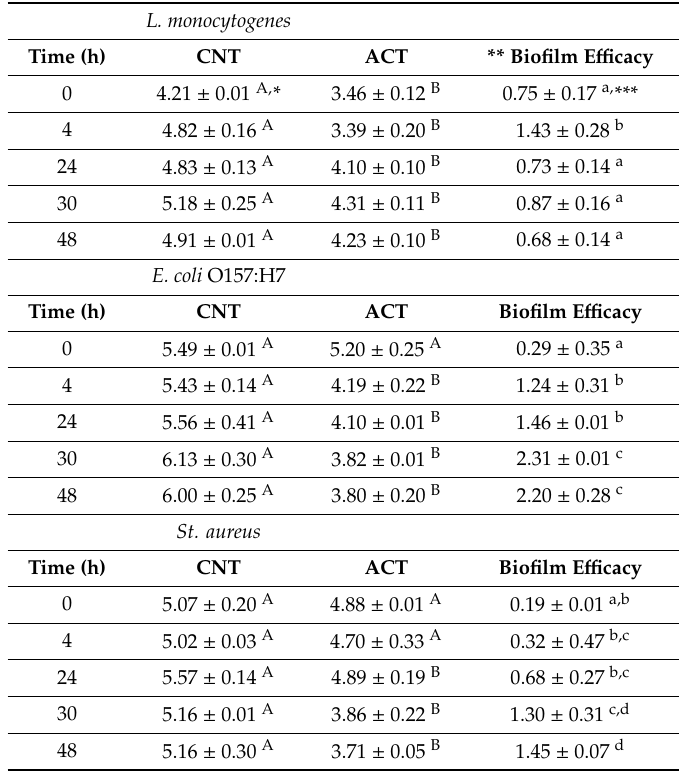
Table 2. Cellular loads (Log CFU / cm 2 ) recovered for Listeria monocytogenes , Escherichia coli O157:H7, Staphylococcus aureus and Salmonella enterica during their sessile growth with (ACTIVE, ACT) or without (CONTROL, CNT) probiotic